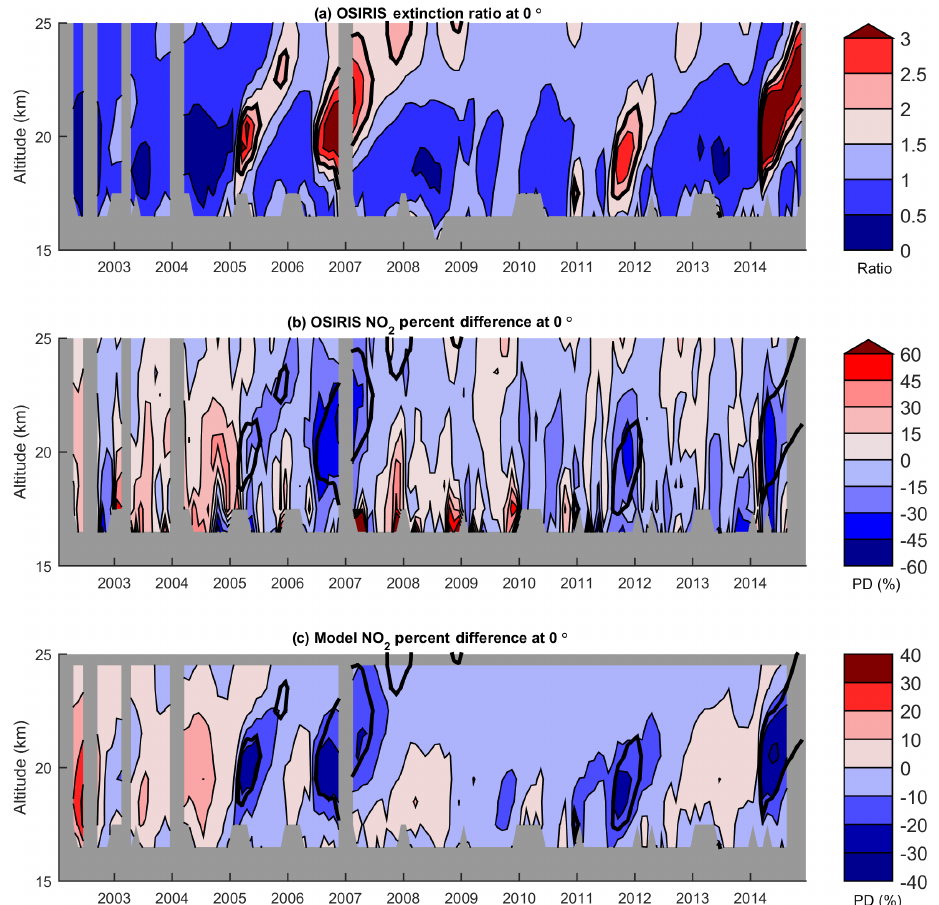
Figure 6. Profiles of aerosol extinction ratio and NO 2 percent difference at 0 ◦ latitude. Time series of (a) OSIRIS extinction ratio, (b) OSIRIS percent difference NO 2 relative to background levels, and (c) modeled percent difference NO 2 relative to background levels. Note that different color-scale ranges are used for the OSIRIS and model percent differences. The thick black contours are for extinction ratios = 2.